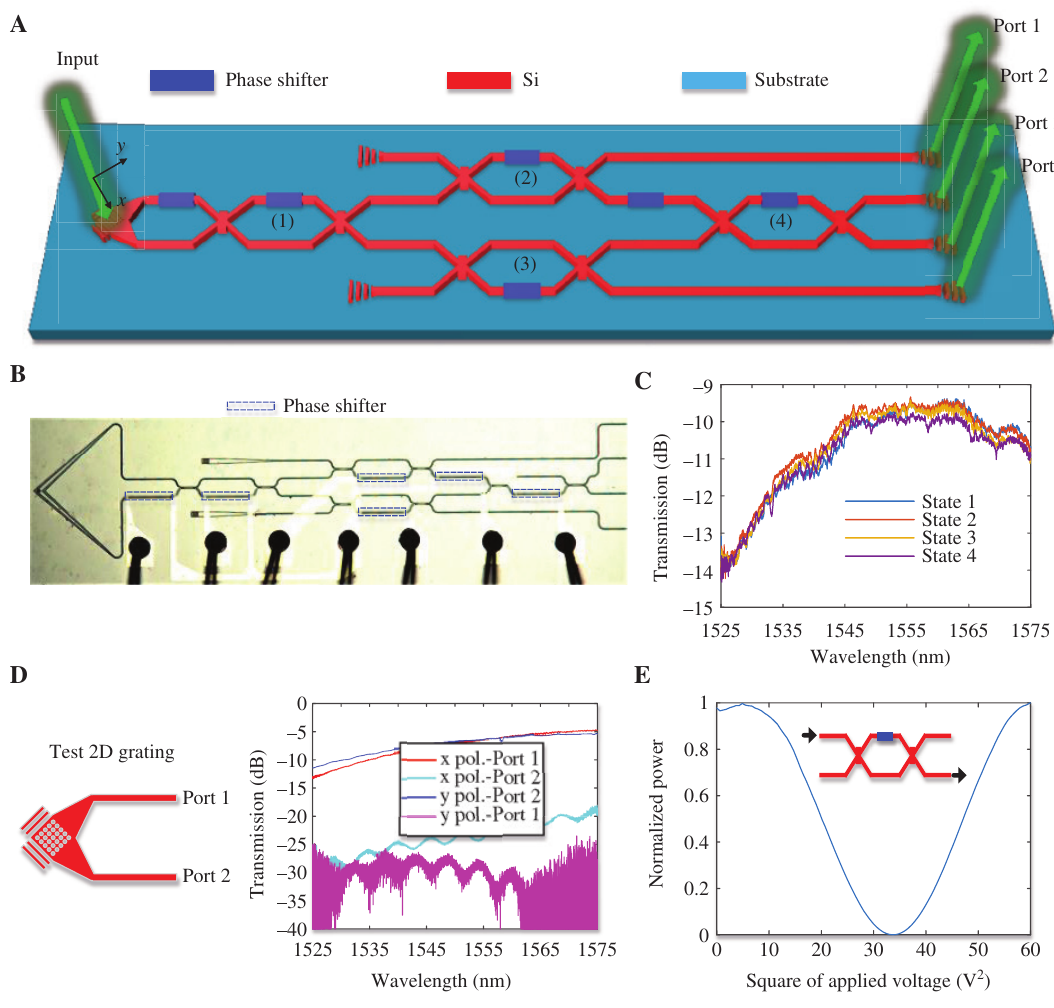
Figure 1: Photonic polarization processing circuits. (A) Detailed structure of the polarization processor chip. (B) Micrograph of fabricated chip. (C) Transmission spectra of the chip for random input SOPs and applied voltages. (D) Transmission spectra of the 2D grating. (E) Imparted phase depending on the applied voltage for the tested MZI